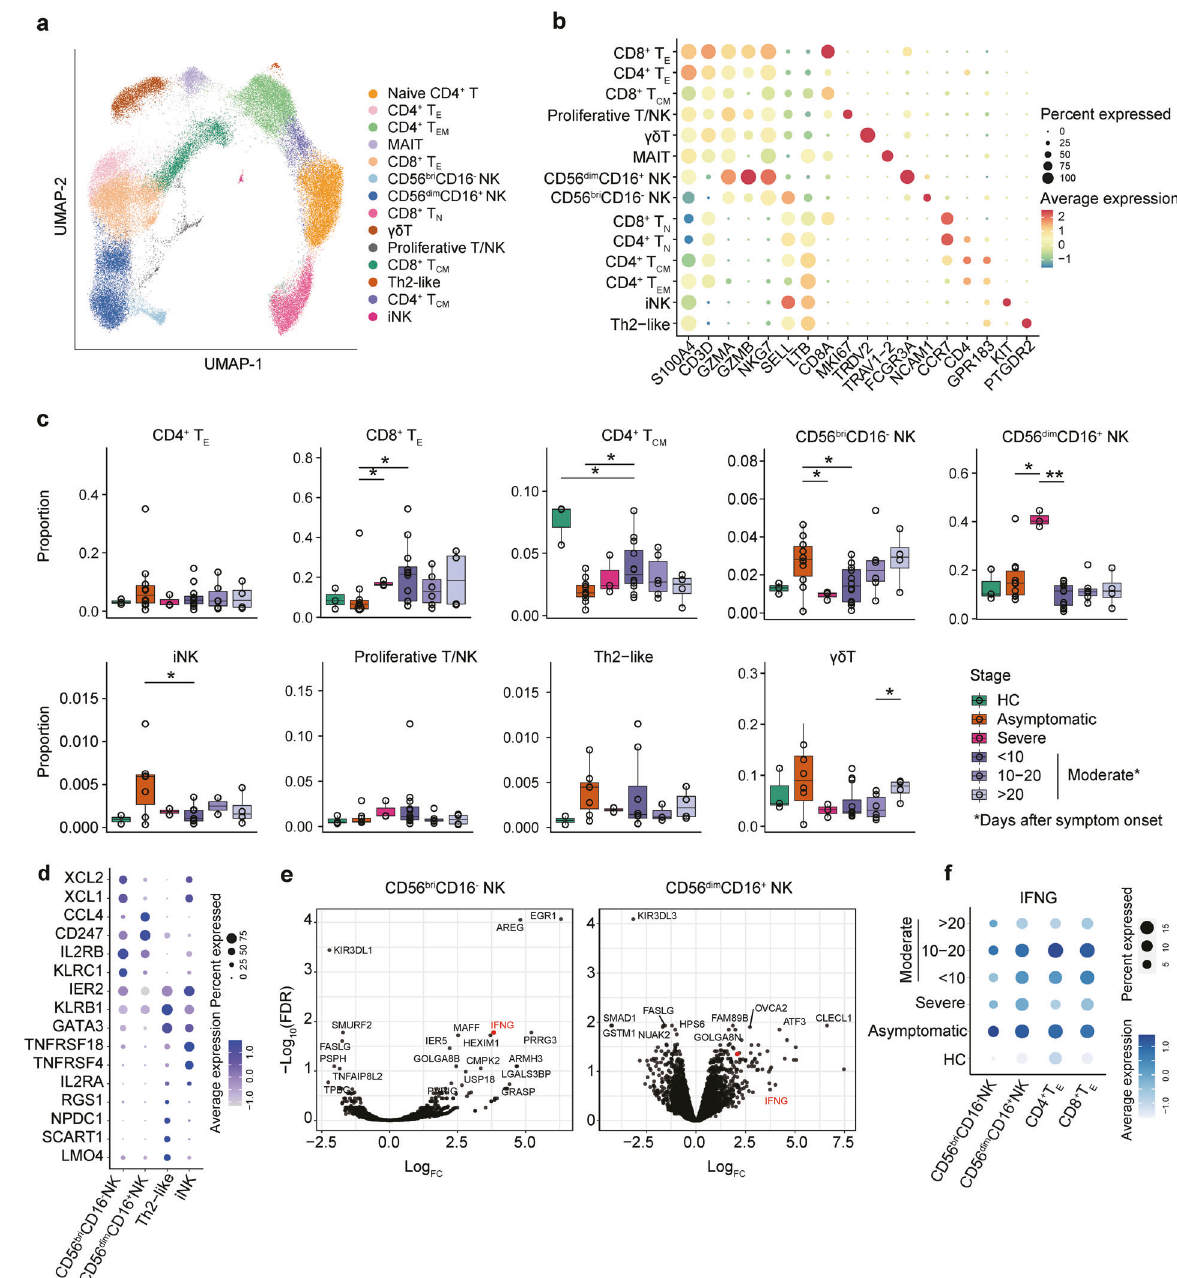
Fig. 3 Identi fi cation and characterization of the subpopulation of T and innate immune cells in COVID-19 patients. a UMAP of T and NK cells by Seurat. Cell types were identi fi ed by the marker genes. Each circle represents an individual cell. A total of seven T cell subtypes and seven innate immune cell subtypes were identi fi ed and color-coded. b Dot plot of average expression and percentage of expressed cells of selected canonical markers in each labeled cell subtype. c Boxplot showing the proportions of cell subtypes to the number T and NK cells in each PBMC sample in different disease conditions. Boxes are colored according to disease conditions and stages of the moderate condition. The PBMC samples from moderate patients were classi fi ed into 3 stages (<10 days, 10 – 20 days, and >20 days) based on the days after symptom onset. Boxplots indicate the median and interquartile range (IQR); the whiskers represent 1.5 times the IQR. Each circle represents the proportion of each sample. Two-sided Kruskal – Wallis test was used for analysis, and a p value < 0.05 is considered signi fi cant. d Dot plot showing the average expression and percentage of expressed cells of selected differentially expressed genes (DEGs) between three NK subtypes and Th2-like subset. e Volcano plots of top DEGs betwe e n asymptomatic and healthy samples for CD56 bri CD16 − (left) and CD56 bri CD16 + (right) NK cell subtypes. Genes with a log fold change above 1 and false discovery rate (FDR, Benjamini – Hochberg) less than 0.05 were selected. f Dot plot showing the expression of IFNG on NK and effect T cells for different disease severity and stages. * p < 0.05, ** p < 0.01, *** p < 0.001. HC healthy control. No asterisk indicates no statistical signi fi cance